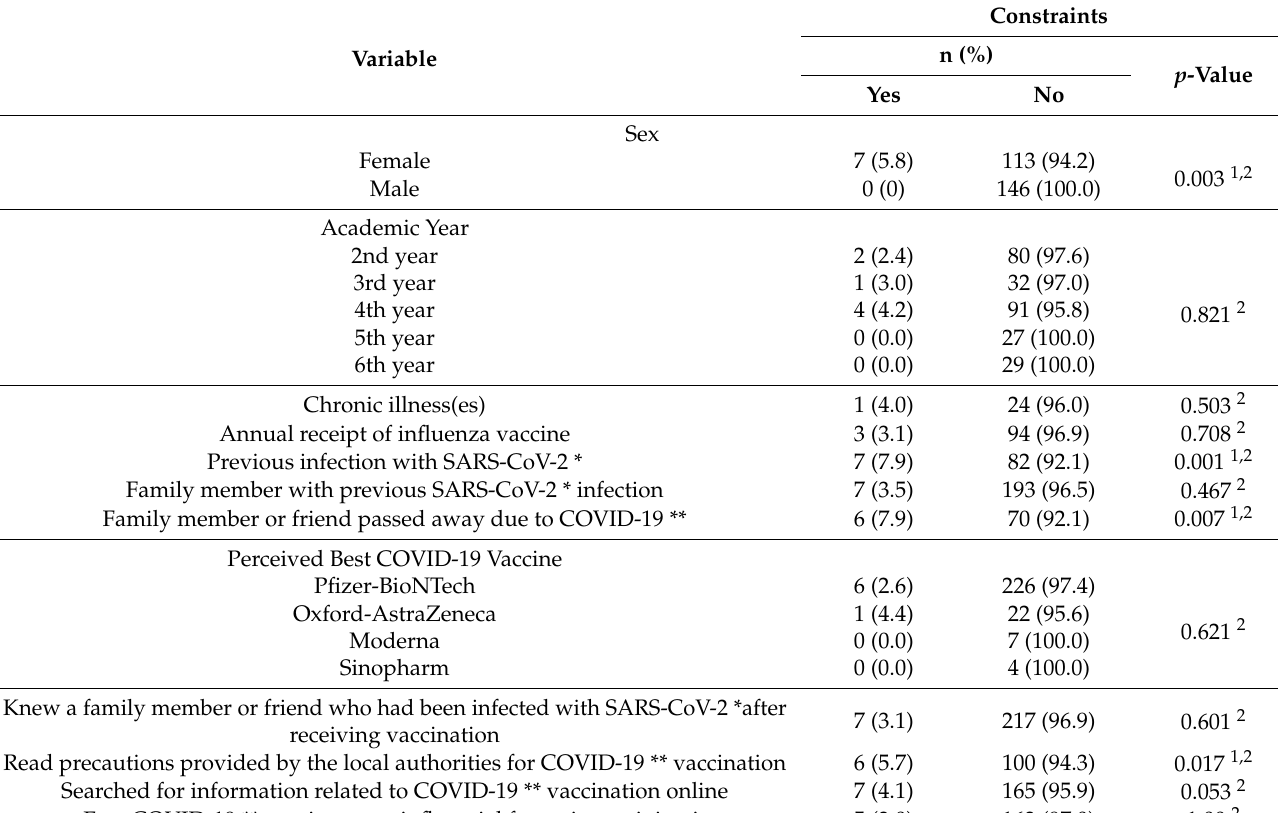
Table 5. Subgroup analysis—constraints.